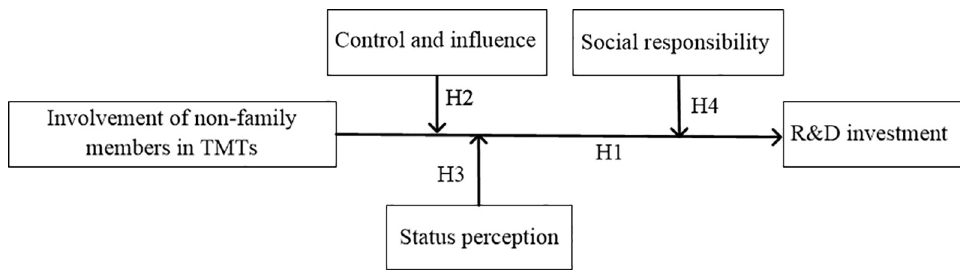
Fig 1. The conceptual framework of